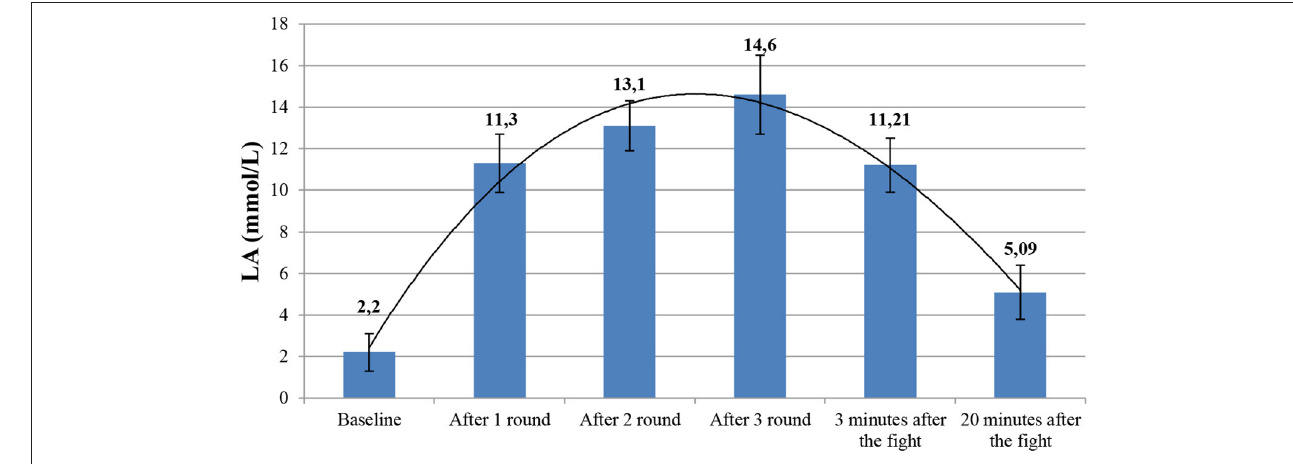
FIGURE 2 | Lactate concentration in subsequent measurements.